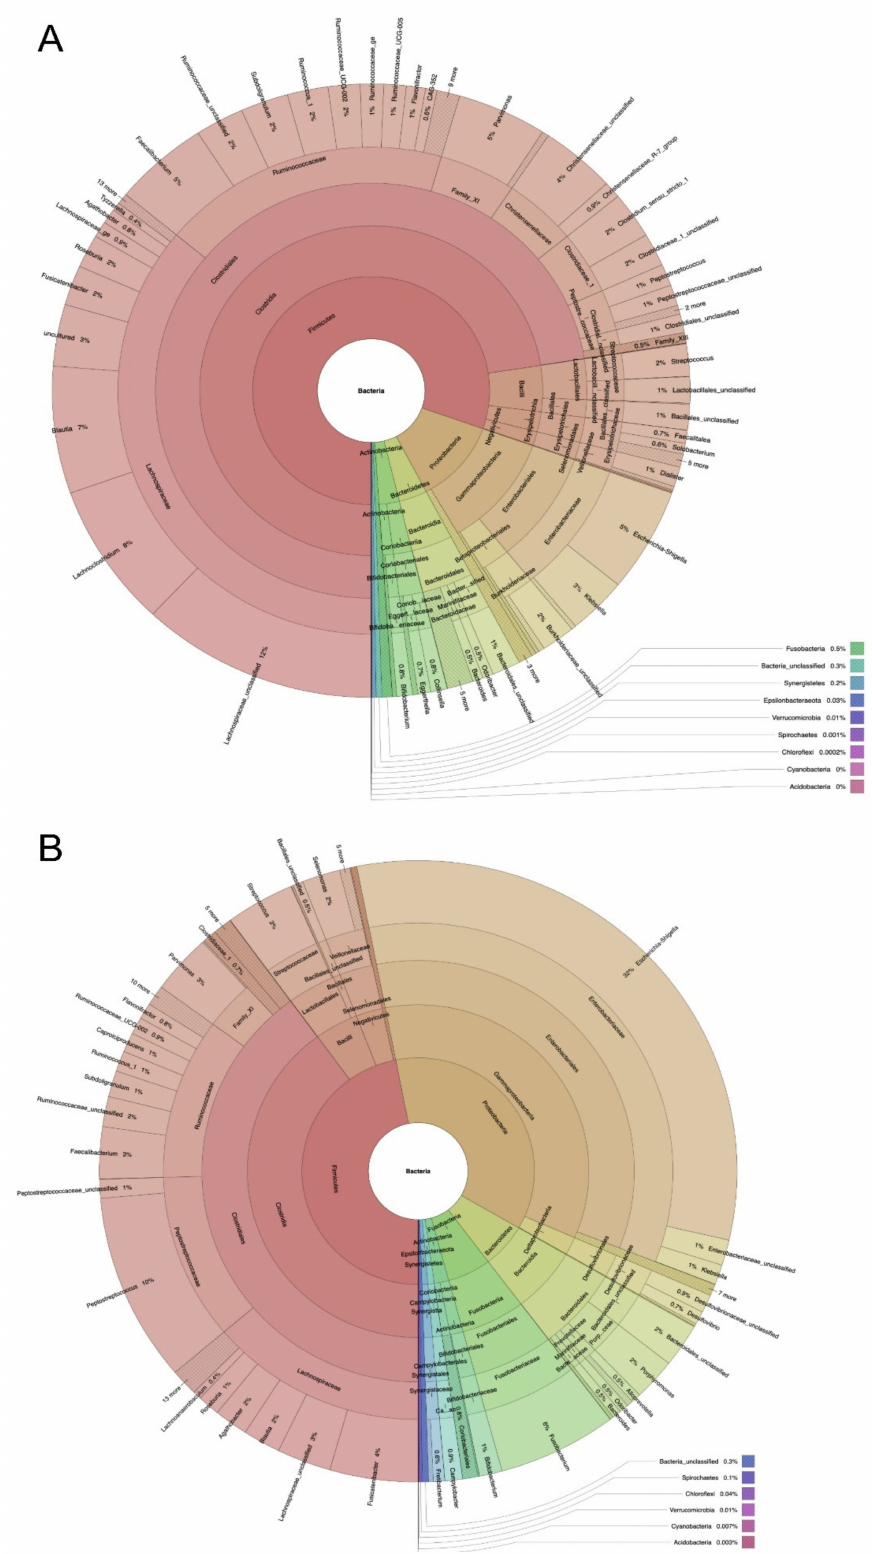
Figure 4. Krona diagrams for illustration of abundance of di ff erent OTUs at the genus level ( A mucosa, B